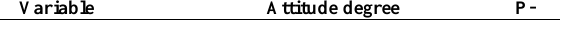
Table 3: Relationship of Attitude degree with participants’ parameters Variable Attitude degree